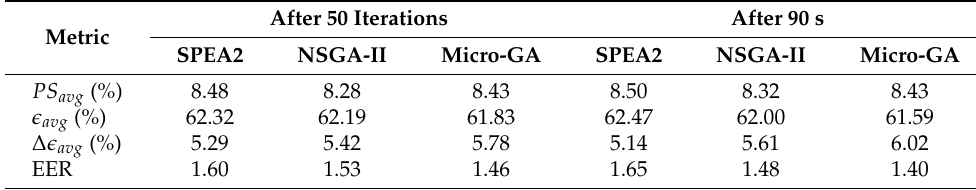
Table 11. Results for the selection of the best algorithm considering both stopping criteria.